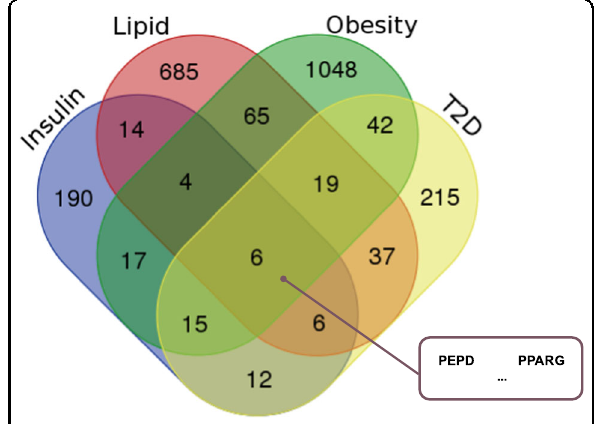
Fig. 1 Genes that were ever reported to be associated with phenotypes relevant to obesity or T2D, which were assessed